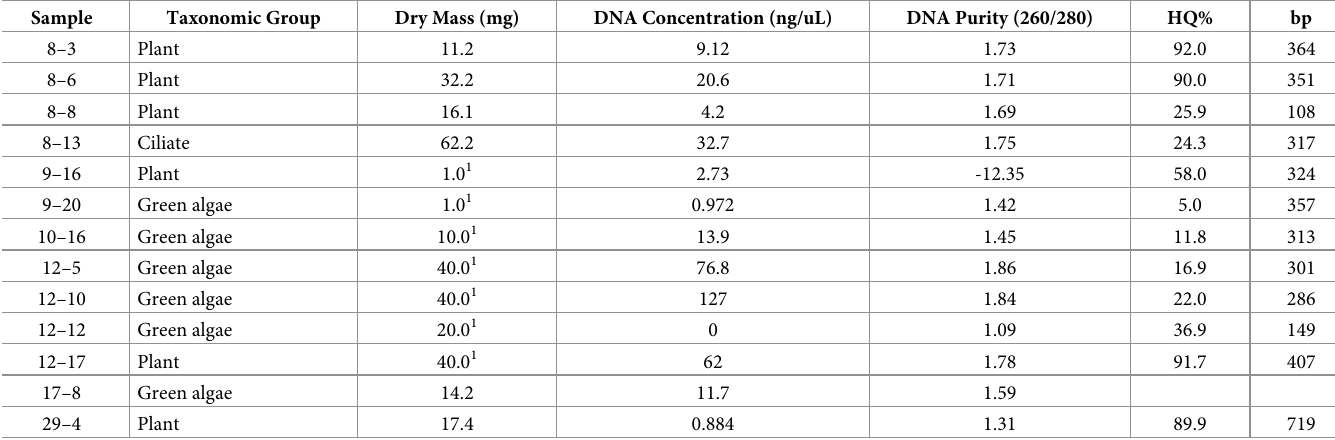
Table 3. Characteristics of successfully sequenced